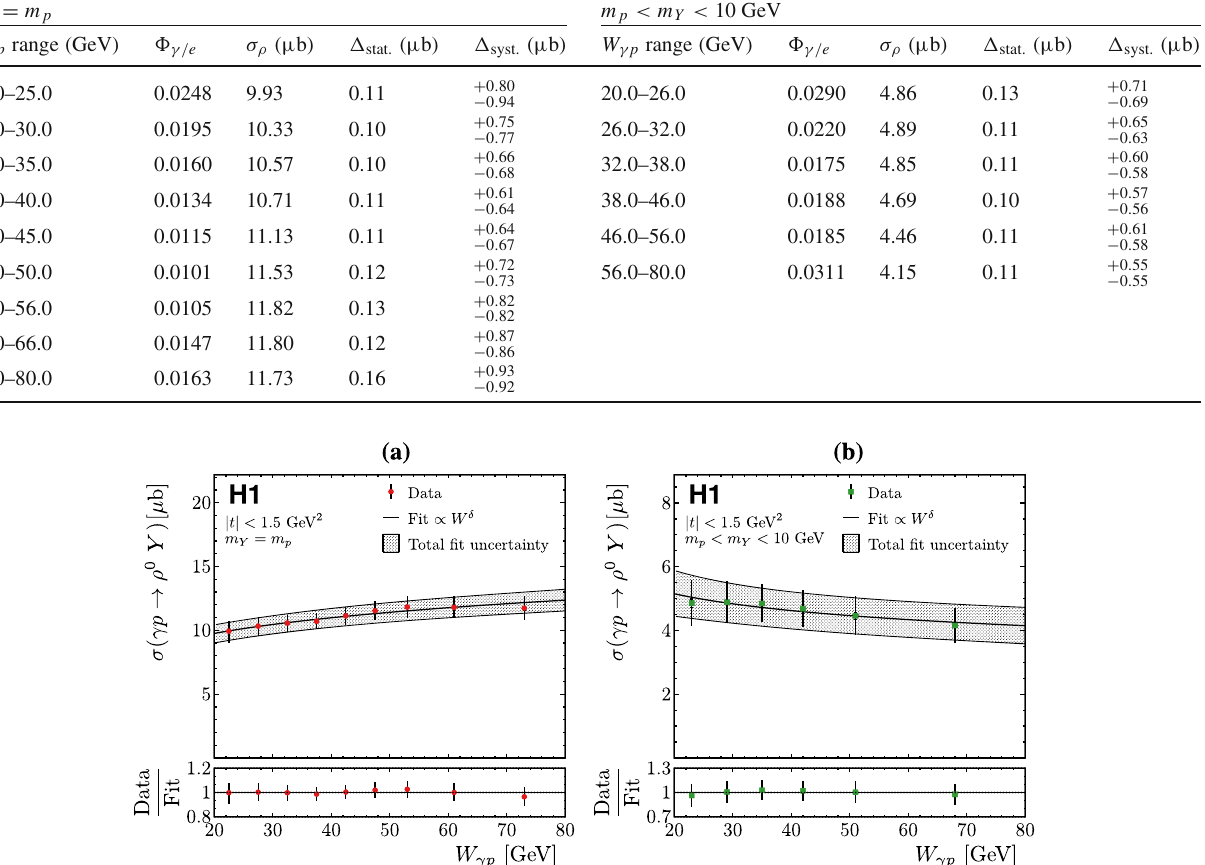
bin are given. The statistical and full systematic uncertainties including normalisation uncertainties are given by (cid:20) stat. and (cid:20) syst. , respectively. A full uncertainty breakdown and statistical correlations are provided [77]. The data are shown in Fig. 10